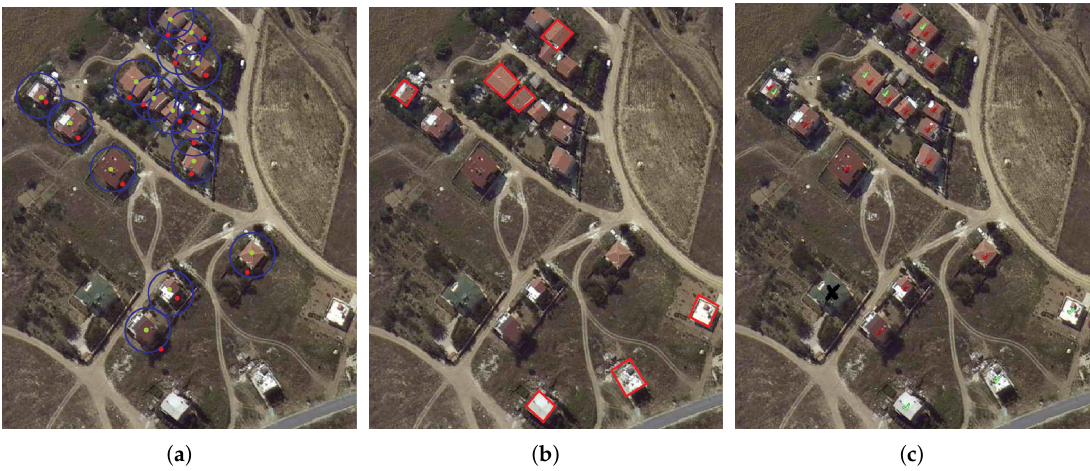
Figure 8. Figure 8a–c show the resultant output of applying TBD, FBD, and results fusion, respectively, on the Ist8 study area.